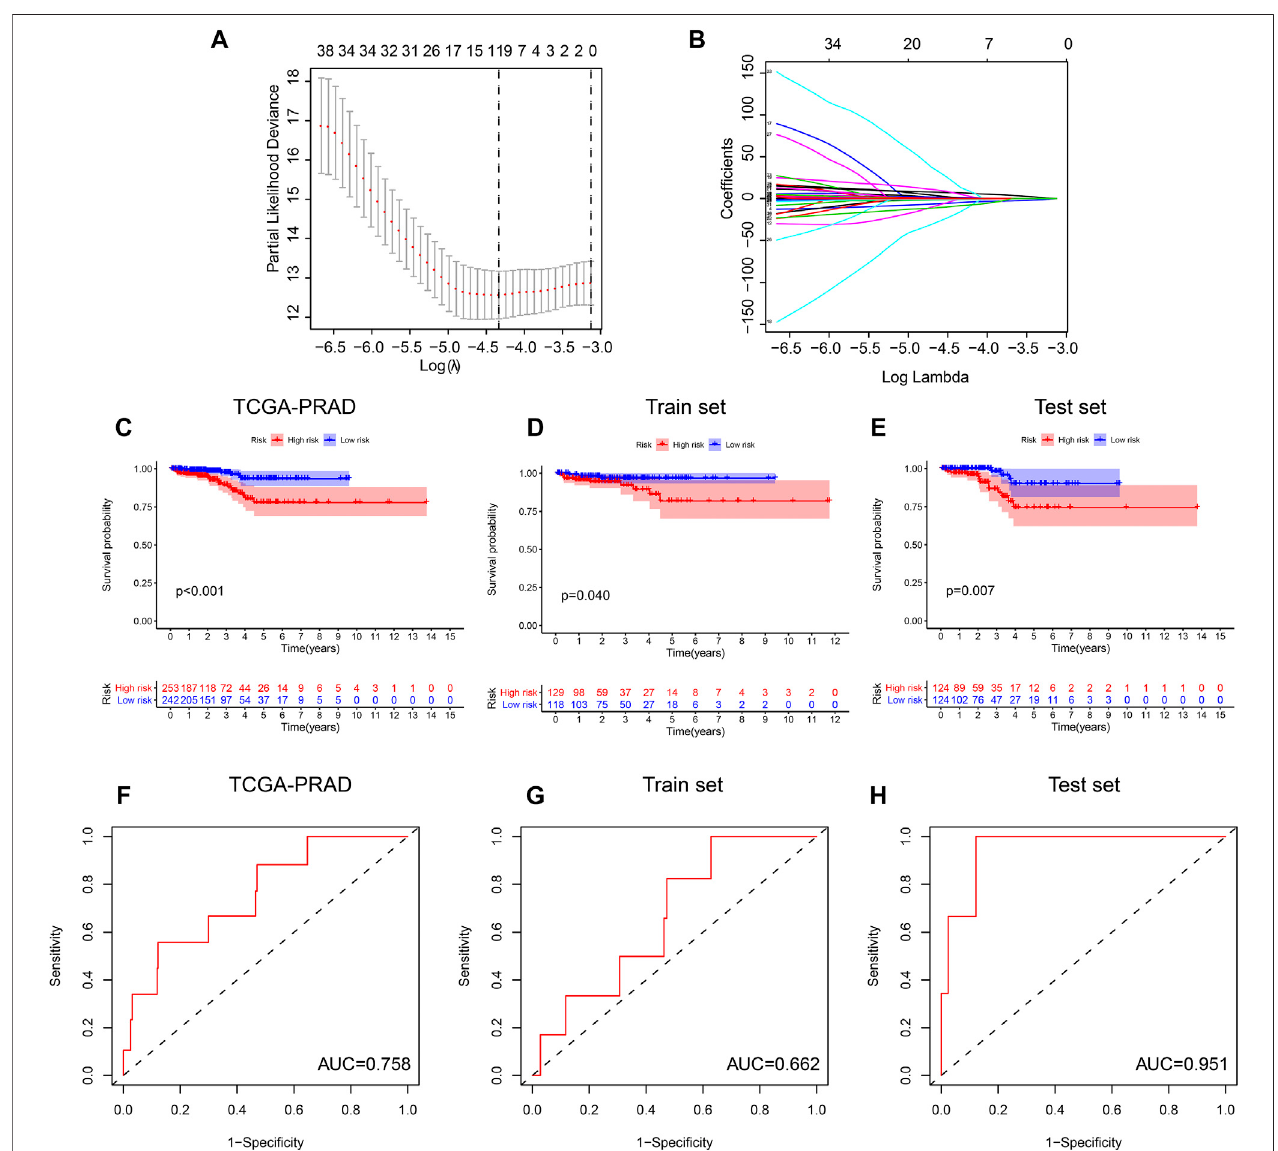
FIGURE 7 | M6A regulator genes methylation prognosis model: (A,B) The process of Lasso regression was shown. (C) The prognostic model of the methylation leveloftheM6AregulatorintheTCGA-PRADcohortcansigni fi cantlydistinguishhigh-andlow-riskpatients( p < 0.001). (D,E) Theclassi fi cationstatisticsoftheriskscore in thetrainingset is p (cid:1) 0.04,theclassi fi cationstatisticsoftheriskscoreinthevalidationsetis p (cid:1) 0.007.(FGH)theAUCareaoftheriskscoreintheTCGA-PRAD cohort was 0.758. The AUC area in the training set cohort is 0.662, and the AUC area in the validation set cohort is 0.951.